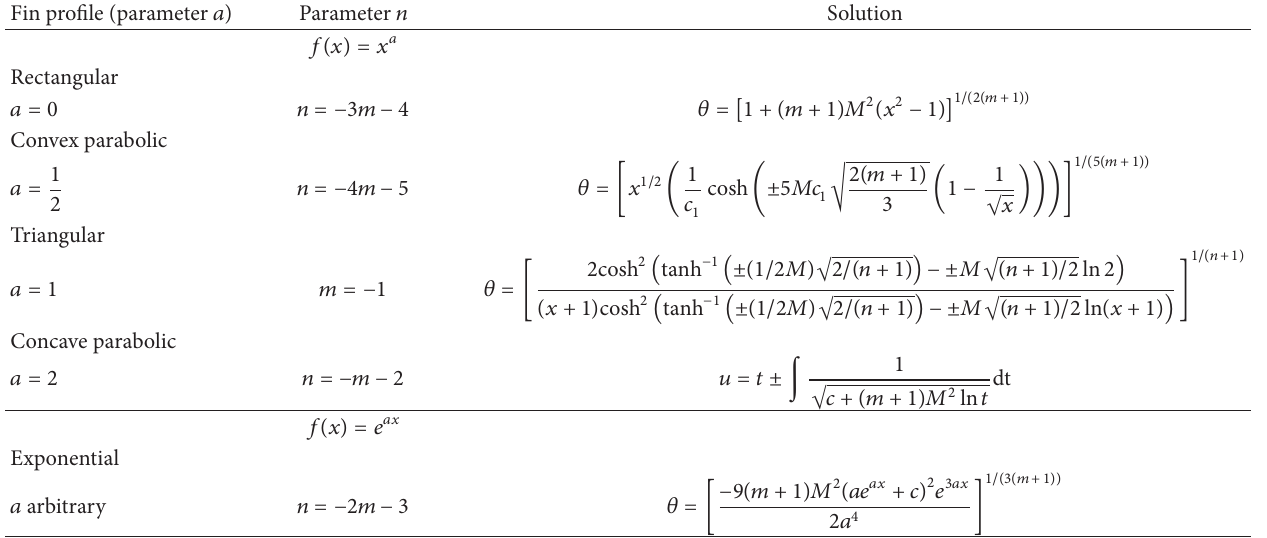
Table 13: Original variables for 𝑚 ̸= 𝑛 , 𝑛 ̸= − 1 and various 𝑓(𝑥)